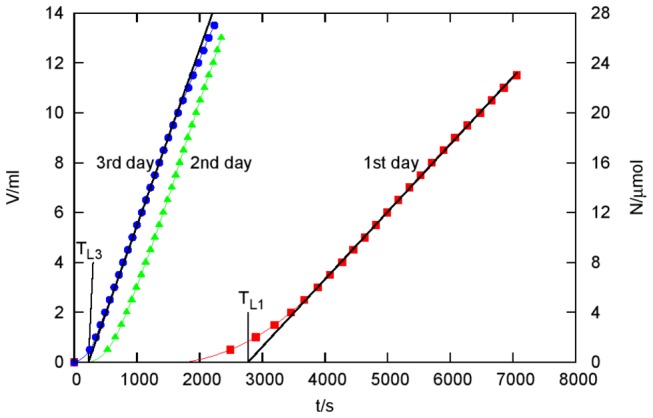
Permeation of ClO2 through a pig bladder membrane as a function of time t.
V and N have the same meaning like in Figure 2. T
L1 = 2770 s, T
L2 = 586 s and T
L3 = 226 s are time lags of the experiments performed on the 1st, 2nd, and 3rd day, respectively. The concentration of the ClO2 source was 946 ppm (14.0 mM) in these experiments.